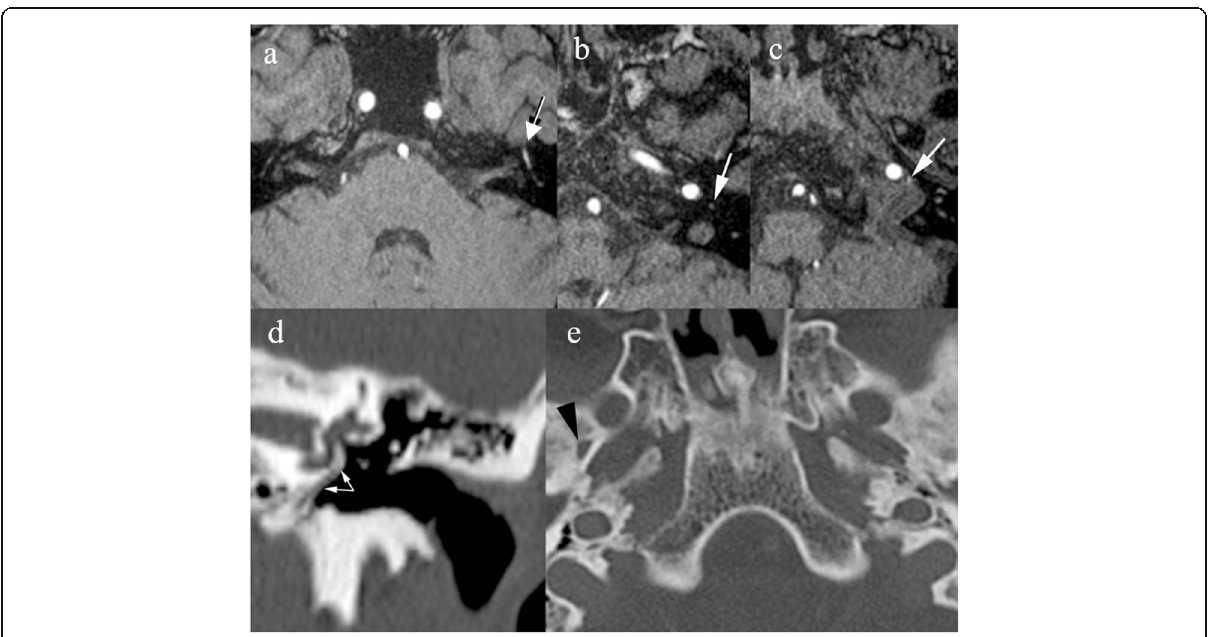
Fig. 13 Persistent stapedial artery. Axial partitions, TOF sequence with selective venous flow suppression ( a – c ). A thin arterial structure (arrows) is seen close to the ICA ( c ) along the promontory ( b ) and along the tympanic segment of the facial nerve ( a ). CT of the brain ( d,e ): coronal multiplanar reformation (MPR) and native axial acquisition. A linear structure runs along the cochlear promontory (arrows), and the left foramen spinosum is absent (black arrowhead points to the right foramen, normally present). Findings are consistent with a persistent stapedial artery